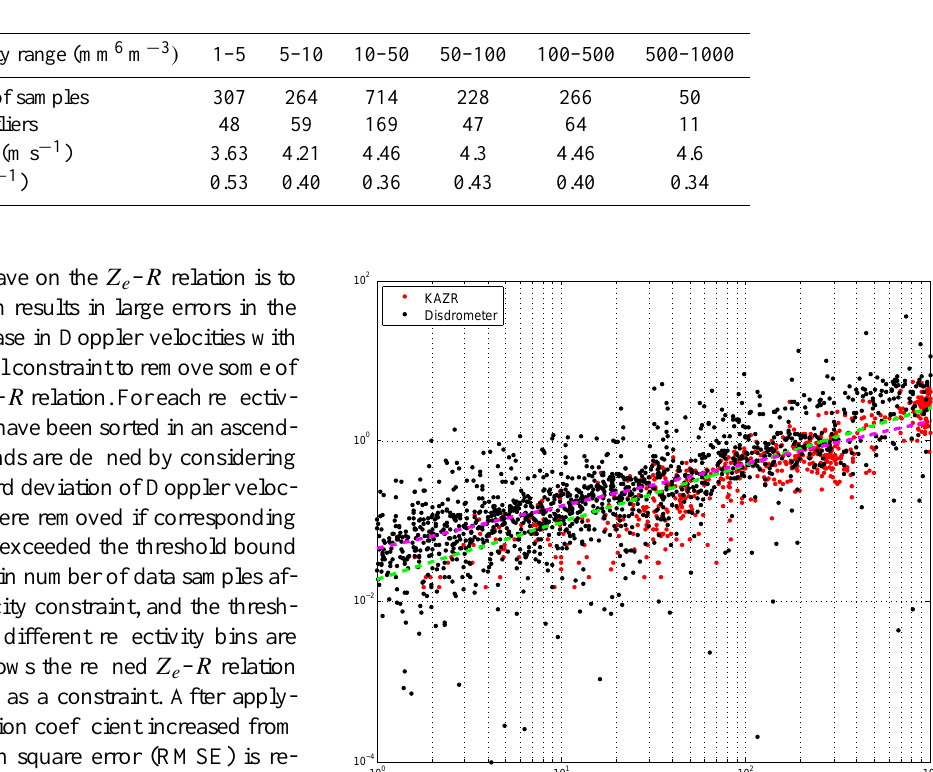
Table 2. Statistics on data sample reduction, and mean and standard deviation of the Doppler velocity (DV) used to constrain the Z e – R relation as shown in Fig. 6. Outliers are removed for the Doppler velocities that are larger than the Doppler velocity bound (mean ± 2SD) for each reflectivity bin.